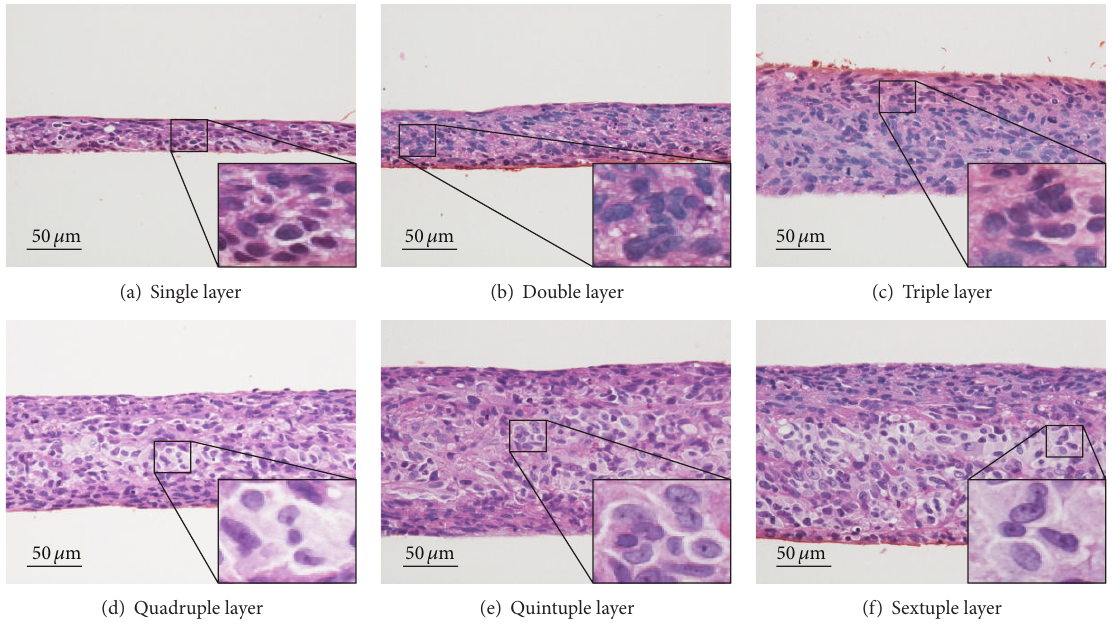
Figure 1: Histological observation of layered human endometrial gland-derived mesenchymal stem cells (hEMSC) sheets after a 24 h cultivation on porous membranes. All microphotographs are the hematoxylin and eosin stained cross-sections of the cell sheets ((a) single- layered cell sheet; (b) double-layered cell sheet; (c) triple-layered cell sheet; (d) quadruple-layered cell sheet; (e) quintuple-layered cell sheet; (f) sextuple-layered cell sheet). Enlarged photographs showed chondrocyte-like cells. Independent three experiments were performed and those experiments showed similar results. The representative photographs were shown in the figure.